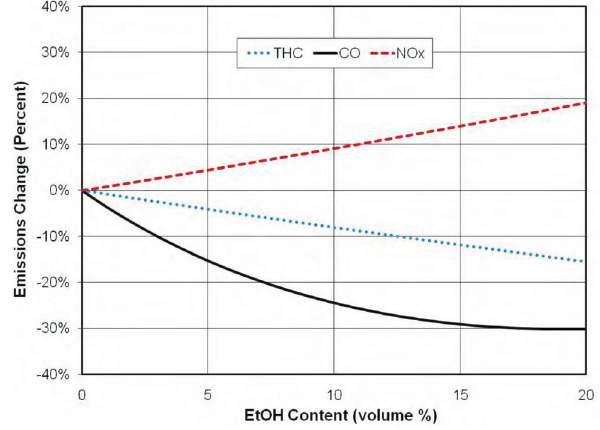
Fig. 3. Trends of emissions of THC, CO and NO Note that the figure shows trends, rather than raw results (taken